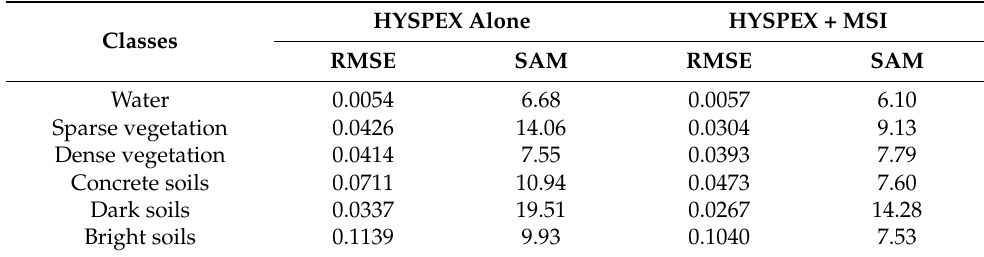
Table 3. Root-mean-square error (RMSE) and spectral angle mapper (SAM) for surface reflectances outside the plume for HYSPEX image alone and the combination of HYSPEX and MSI